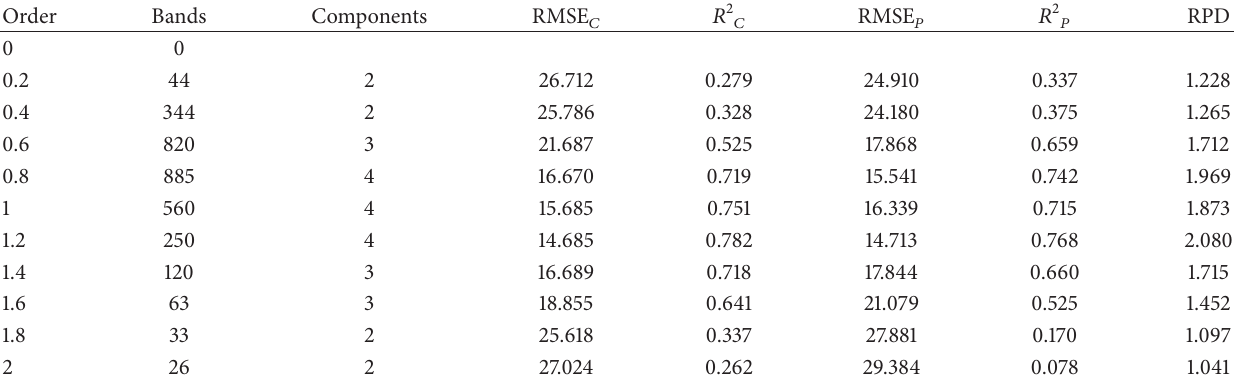
Table 6: The results of the PLSR models based on 1/ lg 𝑅